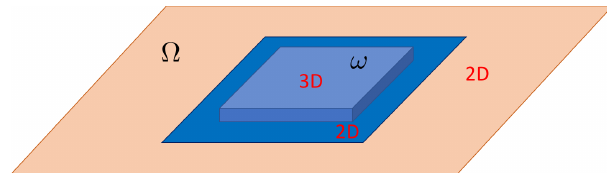
Fig. 2. 2D/3D patch ω immersed into the whole domain Ω .